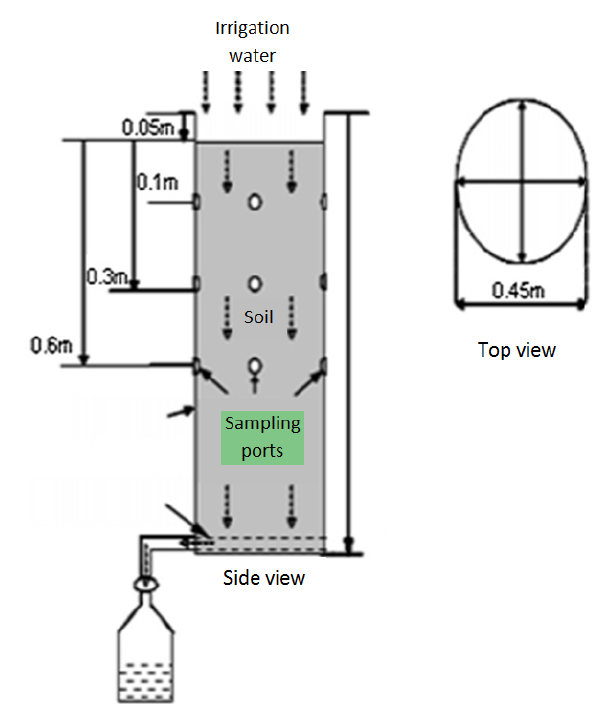
Figure 1. Schematic design of the